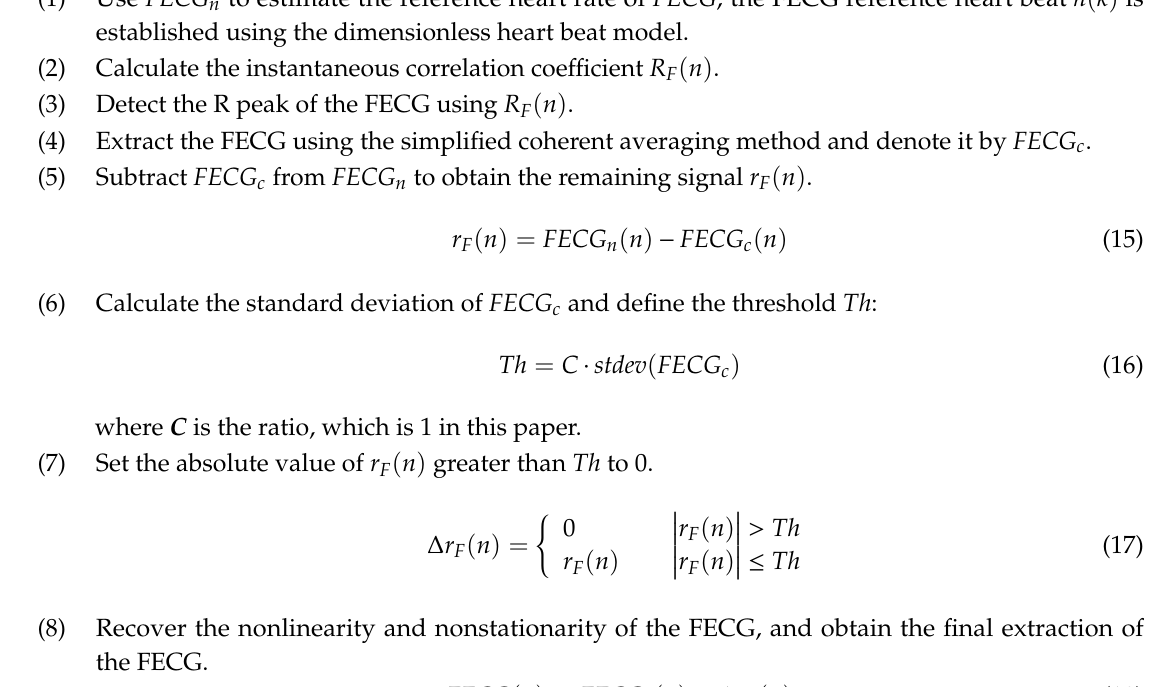
Figure 3. Flow chart of the proposed method. AECG is abdominal ECG and MECG is maternal ECG.